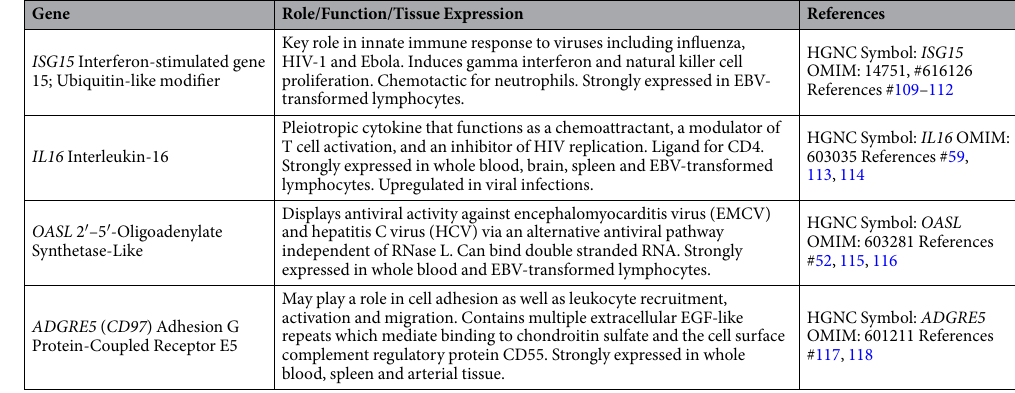
Table 2. RNA transcripts comprising the pan-viral signature. Details of the role, function and tissue expression of the underlying genes are provided along with associated references. ISG15 , IL16 and OASL have previously been directly linked to an immune response to a virus